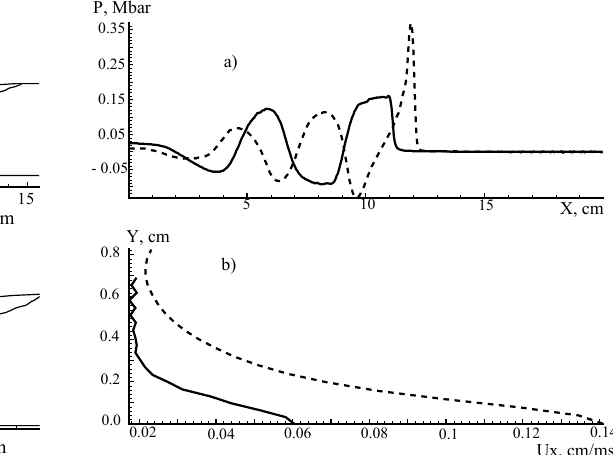
Figure 6: Pressure isolines: a) planar geometry; b) cylindrical configuration.